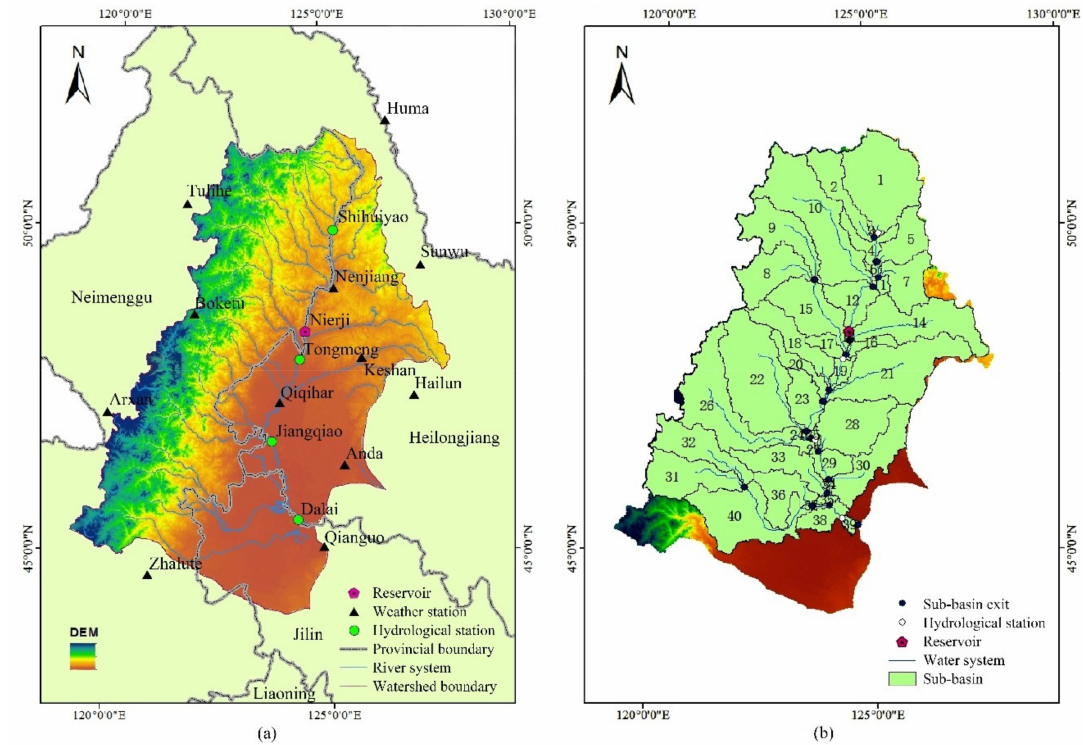
Figure 1. Geological position ( a ) and sub-basin delineation result ( b ) of Nenjiang River